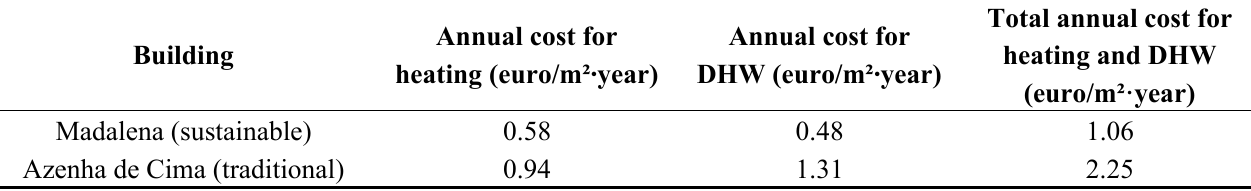
Table 11. Average real energy costs per dwelling—Madalena vs . Azenha de